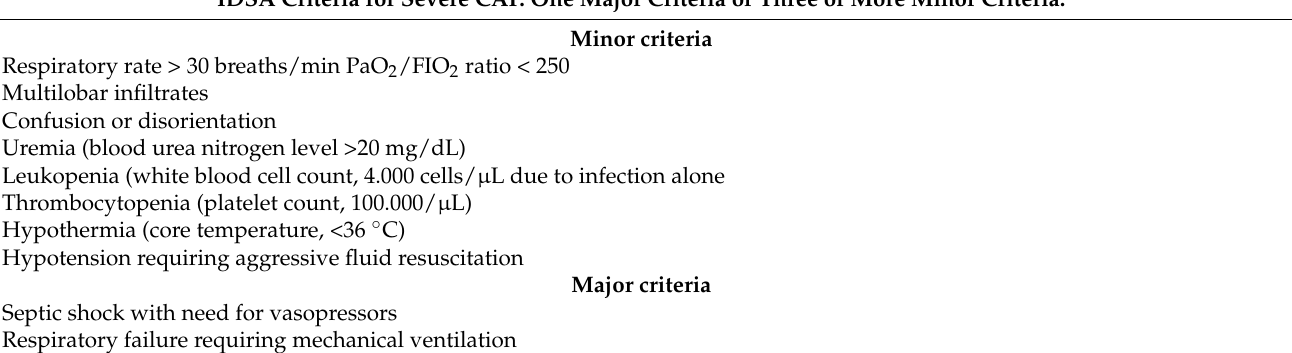
Table 1. IDSA criteria for severity in community-acquired pneumonia (CAP), based on 2019 guidelines. IDSA Criteria for Severe CAP. One Major Criteria or Three or More Minor Criteria. Minor